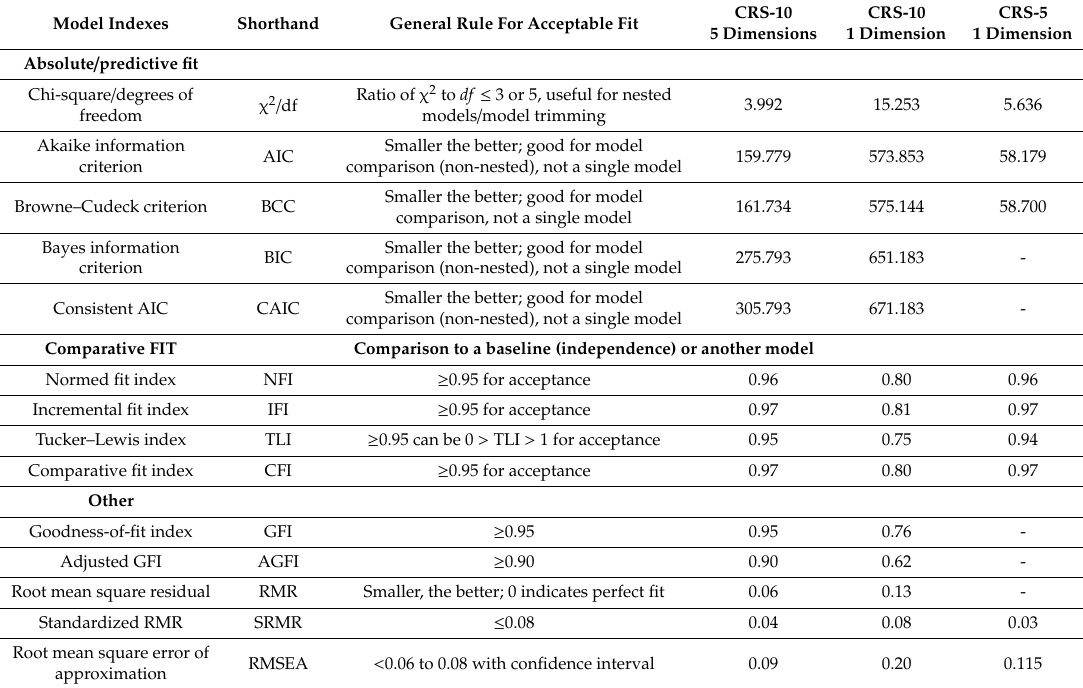
Table A1. Model’s